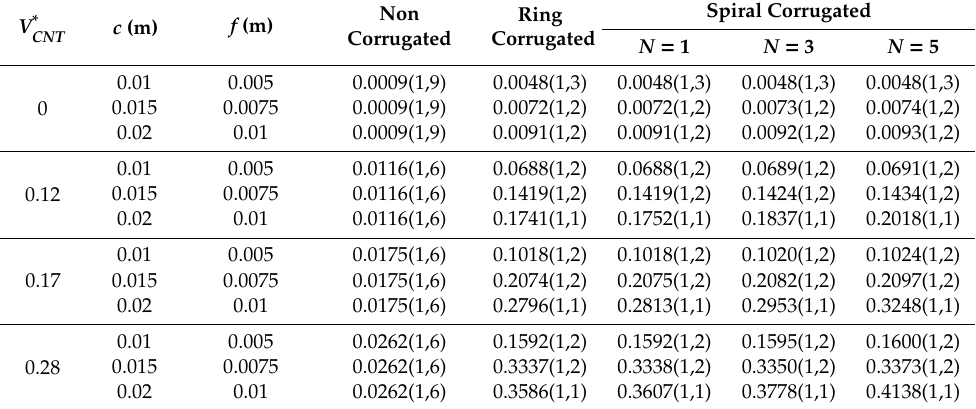
Table 4. Effects of geometrical parameters of corrugation and CNT volume fraction Table 4. E ff ects of geometrical parameters of corrugation and CNT volume fraction V ∗ buckling of UD-CNTRC cylindrical shells (trapezoidal corrugation, α = π / 3) (in MPa).